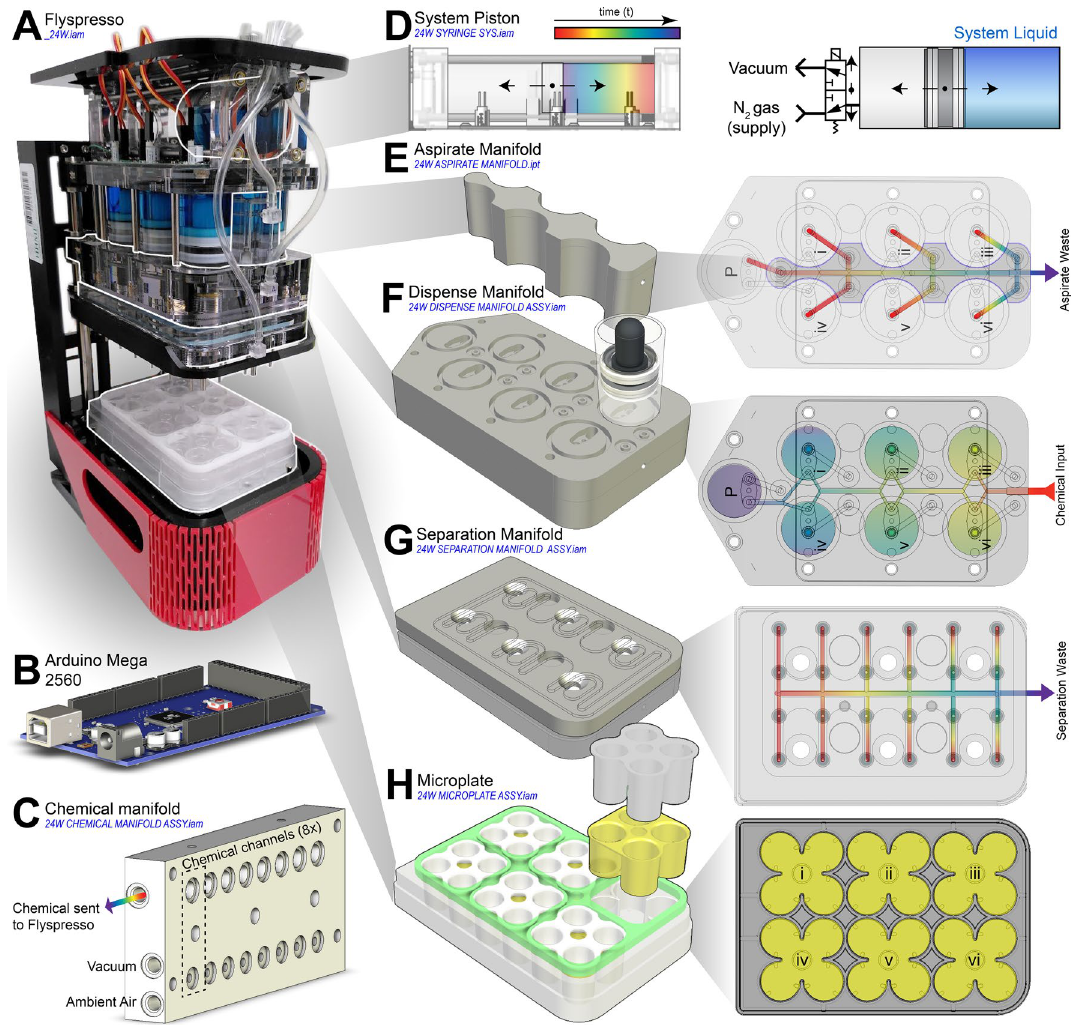
Figure 2. Flyspresso components and design. ( A ) Photograph of the Flyspresso robot (_24W.iam), composed of (from top to bottom) the System Piston, Aspirate Manifold, Dispense Manifold, Separation Manifold, Microplate, and the Heating and Shaking Device. ( B ) The syringes and the chemical manifold are controlled by an Arduino Mega 2560 microcontroller, which communicates internally with a python interpreter on a computer with the specific protocol. ( C ) The Chemical Manifold (24 W CHEMICAL MANIFOLD ASSY.iam) can be expanded to the number of channels needed for each experiment. Each chemical channel is controlled by a solenoid valve, which is dictated by the Arduino microcontroller. Chemicals not in use are held via vacuum, and the desired chemical is pulled into Flyspresso when the solenoid valve switches to ambient air (see also Fig. 3). ( D–H ) Exploded-view of Flyspresso . ( D ) Schematics of the System Piston. Color schematic from red to violet corresponds with the piston’s position when pulling liquid into the system (24 W SYRINGE SYS. iam). The System Piston moves a System Liquid to control the other syringes. Movement is controlled by a gas and vacuum supply (see also Fig. 3). ( E ) (Left) The Aspirate Manifold (24 W ASPIRATE MANIFOLD.ipt) sits between the Chemical Syringe Pumps. (Right) Top view of the Aspirate Manifold laying on the Dispense Manifold. Chemical waste is pulled through the Aspirate Manifold to a waste container. ( F ) (Left) The Dispense Manifold (24 W DISPENSE MANIFOLD ASSY.iam) holds a Priming Syringe Pump (P) and 6 Chemical Syringe Pumps (i–vi). (Right) Top view of the Dispense Manifold shows the chemical pathway to either the Priming Syringe Pump (P) or the 6 Chemical Syringe Pumps (i–vi). ( G ) (Left) The Separation Manifold (24W SEPARATOR ASSY.iam). (Right) Top view of the Separation Manifold. The Separation Manifold is equipped with 24 separator tips, which aspirate liquid from the upper interface to Separation Waste. ( H ) The custom microplate (24 W MICROPLATE ASSY.iam) sits below the Separation Manifold and holds 6 Transplates (yellow) (24W TRANSPLATE.ipt) for a total of 24 samples. Seplate Attachments (gray) (24W SEPLATE.ipt) sit above the Transplates and enclose the embryos, separating the upper and lower liquid